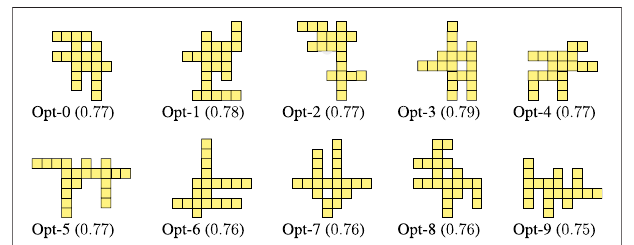
FIGURE 5 | Morphologies evolved for criticality together with the corresponding value of criticality.